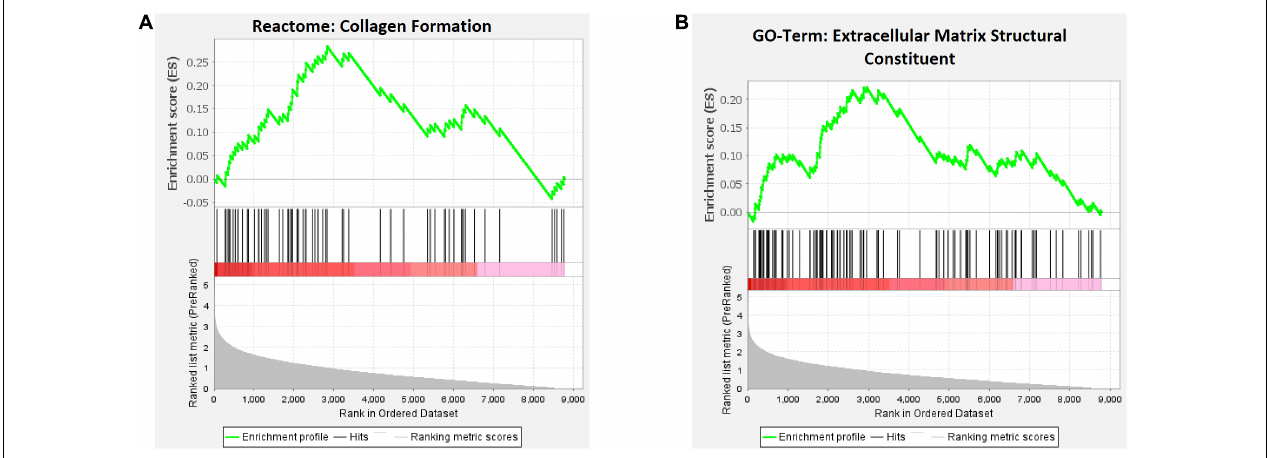
FIGURE 3 | Top-enriched reactome pathway (A ) and GO-term (B) for genes pre-ranked by their top SNP association p -value for epileptic seizure among protein-altering variants. The analyses were performed on a total of 8,802 genes with human homologs with the program GSEA v. 4.1. Computation of the running enrichment score was unweighted, with “hits” representing the pre-ranked genes belonging to the curated gene